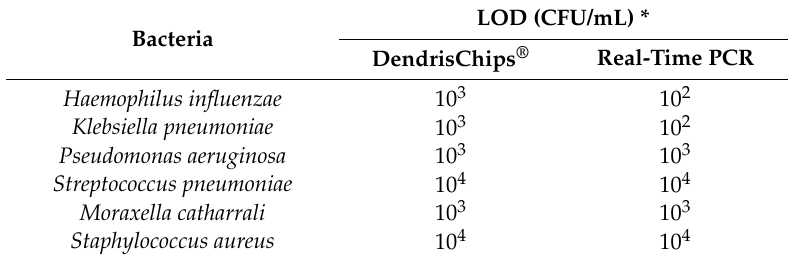
Table 3. Evaluation of the limit of detection (LOD) of the method and comparison with real-time PCR. LOD (CFU/mL) * Bacteria DendrisChips ® Real-Time PCR Haemophilus